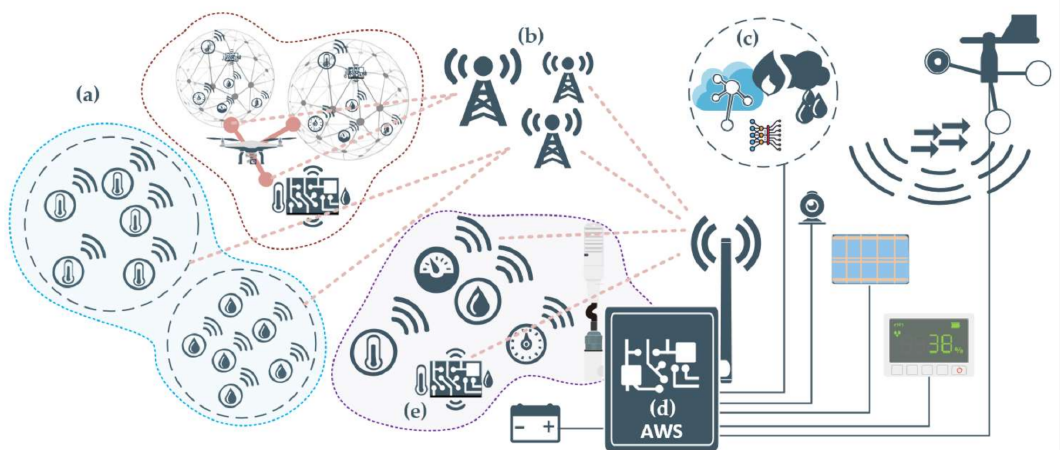
Figure 9. Low-Cost Automatic Weather Stations in the Internet of Things: ( a ) Mesh collections of sensors, ( b ) Wireless networks (Low-Power Wide-Area Network (LPWAN), 4G, 5G, etc.), ( c ) Advanced computing capabilities and algorithms, ( d ) Advanced hardware features, and ( e ) Intelligent sensors and measurement